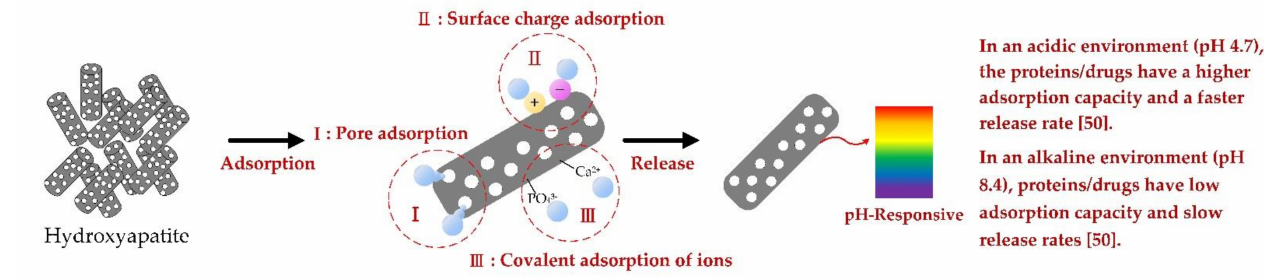
Figure 1. Schematic diagram of the adsorption and attachment factor mechanism of porous HA nanorod